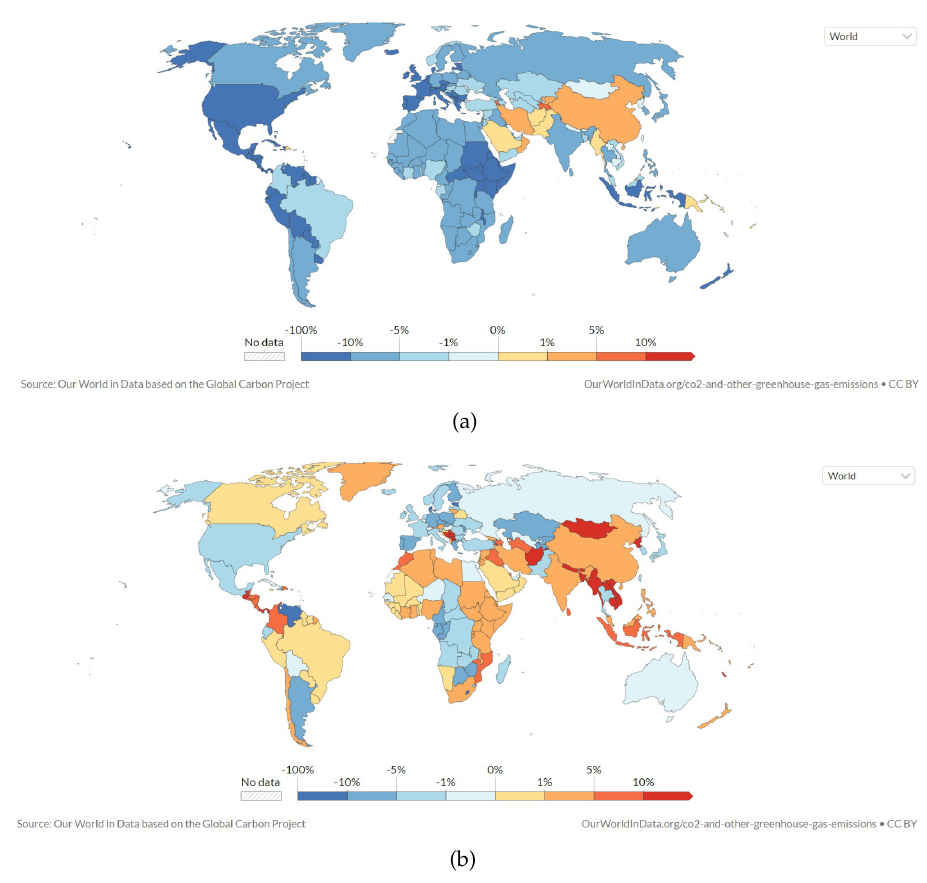
(b) Figure 3. Week by week change in confirmed COVID-19 cases: (a) March 2020, (b) March 2021.